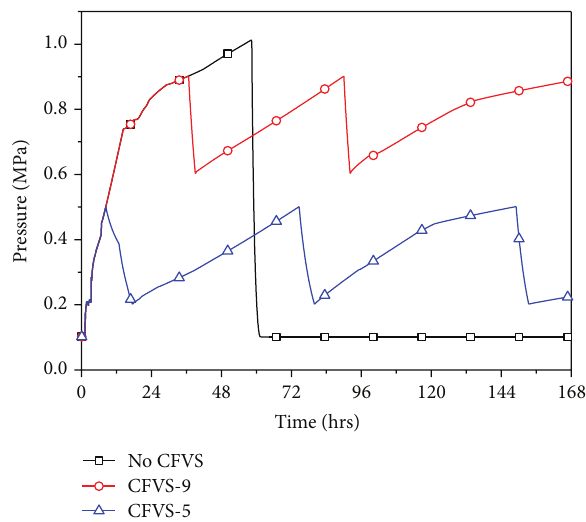
Figure 2: Containment pressure history in extended